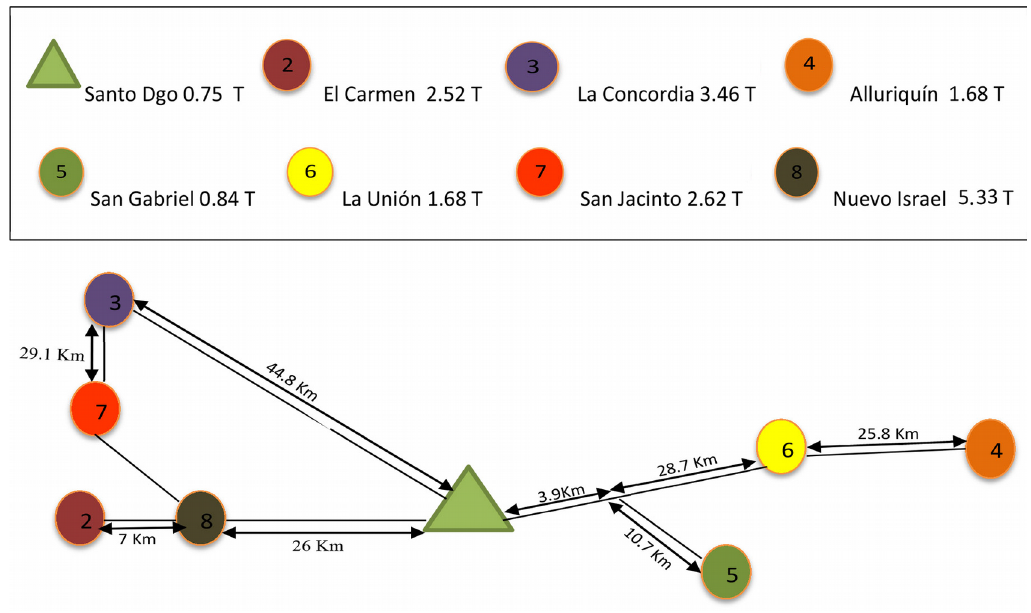
Figure 2. Improved route location